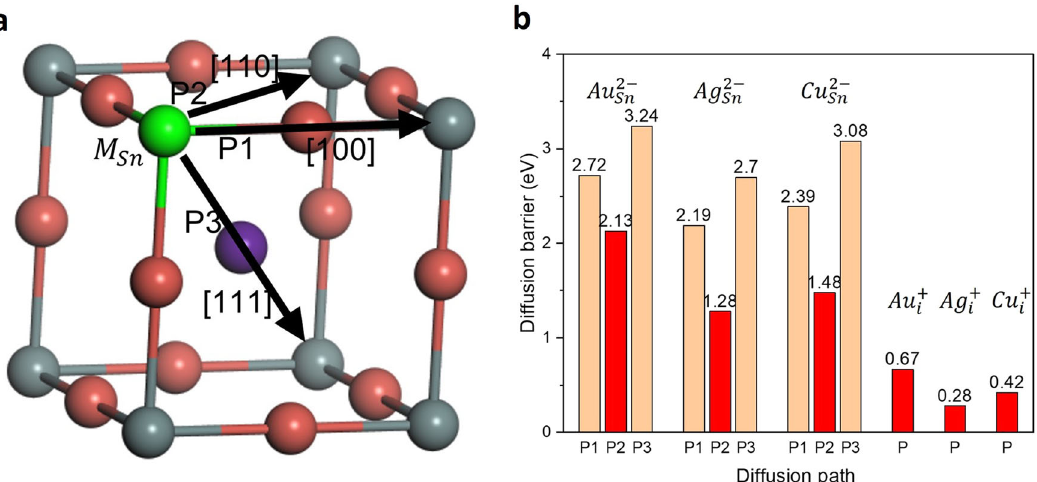
Fig. 3 The diffusion of major impurities. a The diffusion paths for substitutional impurities ( M = Au, Ag, Cu ) in α -CsSnBr 3 . The green spheres depict metal elements ( Au, Ag, Cu ), the red one Br , the gray one Sn , and the purple one Cs . b The calculated diffusion barriers for the metal impurities of Au 2 (cid:2) , Ag 2 (cid:2) , Cu 2 (cid:2) , Au þ , Ag þ , and Cu þ . The red bars stand for the main modes of diffusion (lowest barrier), and the pink ones for Sn Sn Sn i i i , Ag 2 (cid:2) , and Cu 2 (cid:2) ), P1, P2, and P3 represent the diffusion directions of [100], the less favorable modes. For the substitutional impurities ( Au 2 (cid:2) Sn Sn Sn [110], and [111], respectively.